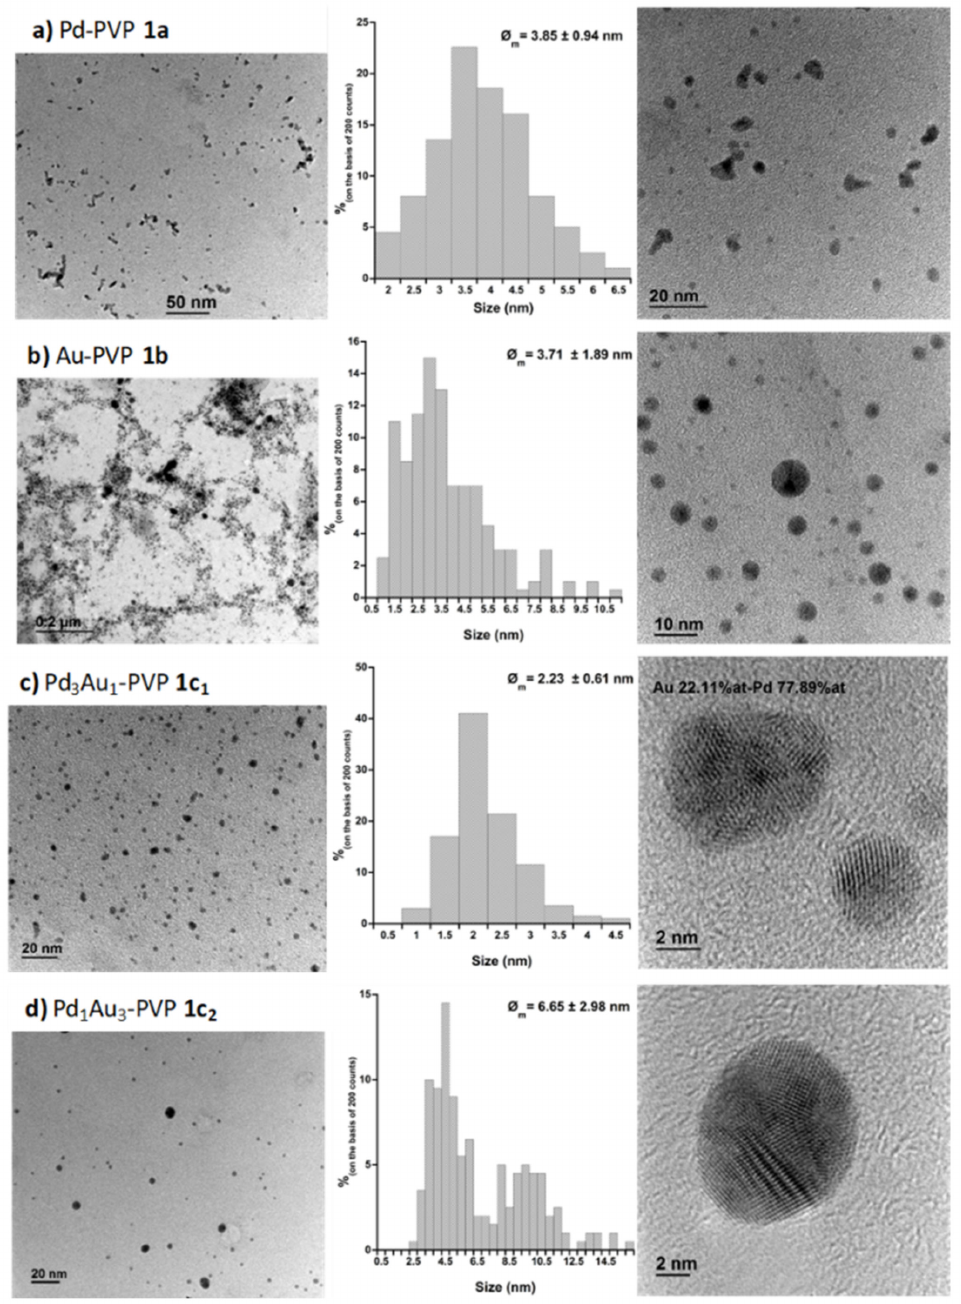
Figure 2. TEM pictures and size distribution of the different nanoparticle systems of Family 1. ( a ) Obtained from Na 2 PdCl 4 . ( b ) Obtained from HAuCl 4 . ( c , d ) Obtained from Na 2 PdCl 4 and HAuCl 4